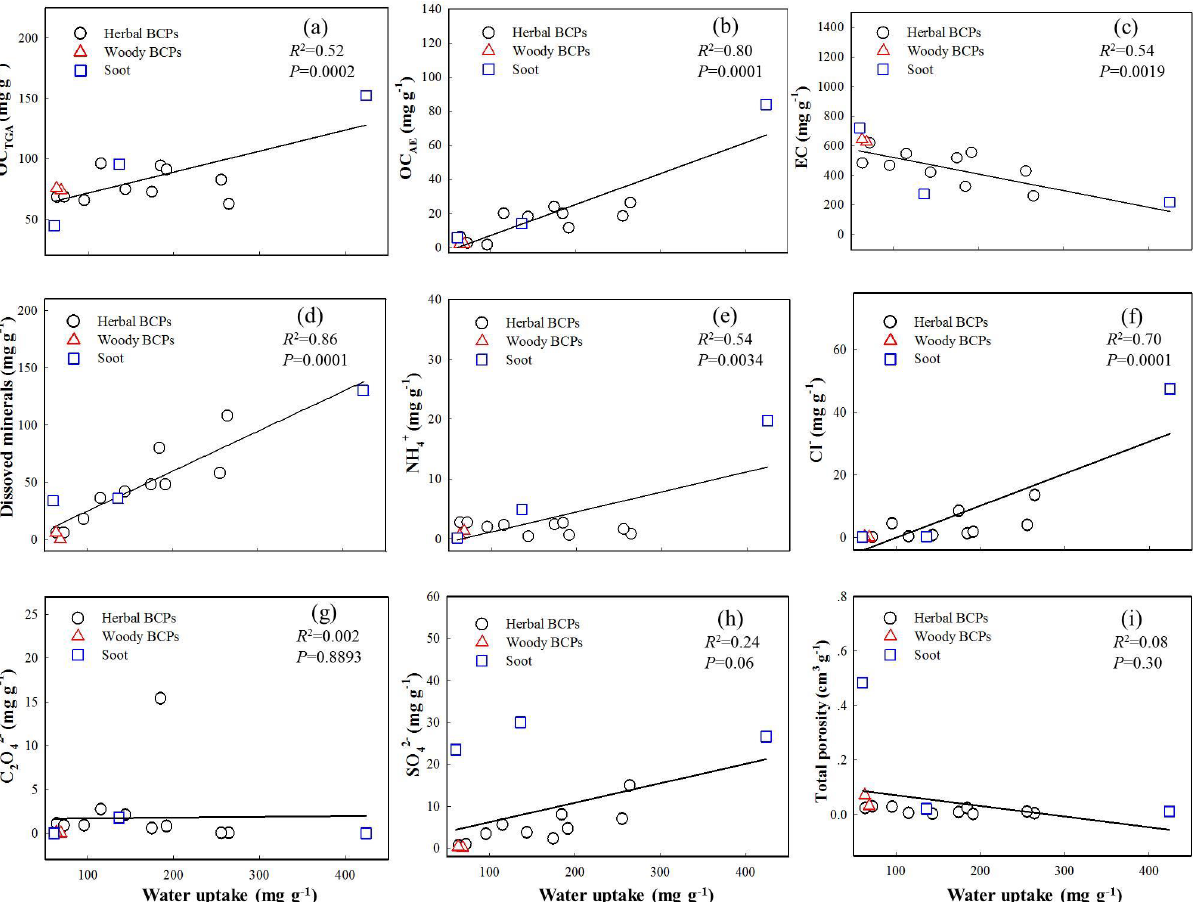
Figure 2. Relationships between equilibrium water uptake (mgg − 1 ) vs. compositional and pore property parameters for the group of BCPs at 94% relative humidity. (a) TGA-measured organic carbon (OC TGA ). (b) Alkali-extracted organic carbon (OC AE ) . (c) Elemental carbon (EC). (d) Dissolved minerals. (e) Ammonium (NH +